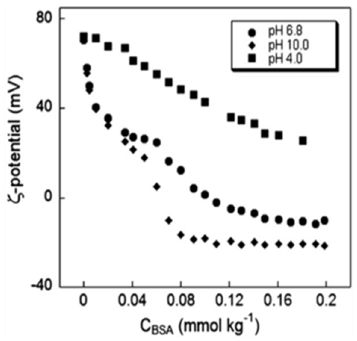
Figure 10. Essential chemico-physical parameters of a typical cat-anionic vesicle. There existed a surface charge density, expressed as zeta potential, of dispersions of cat-anionic vesicles to which bovine serum albumin was added. Experiments were performed at three pH values, and 25 ◦